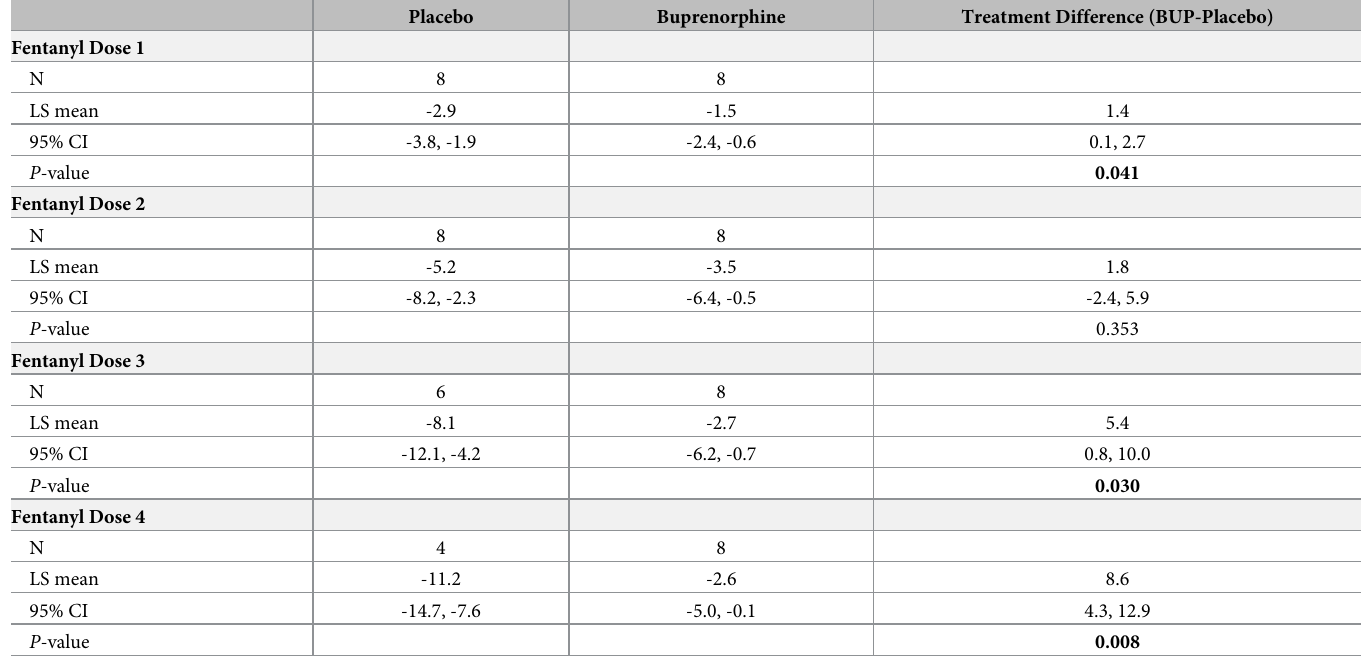
Table 4. Maximum change from pre-fentanyl baseline in oxygen saturation (%) in opioid-tolerant